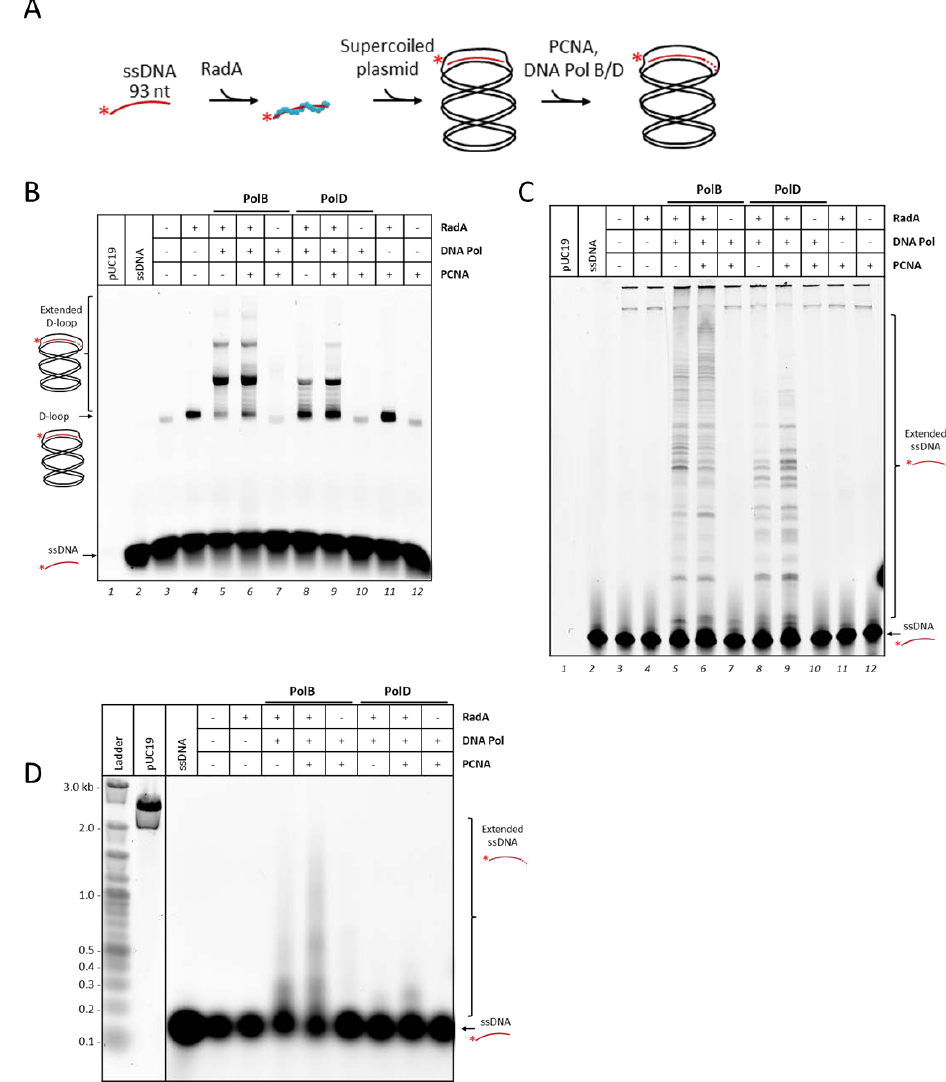
Figure 2. Addition of PCNA stimulates DNA extension by DNA polymerases on recombination intermediates. ( A ) Schematic representation for DNA extension by family-B polymerase (PolB) or